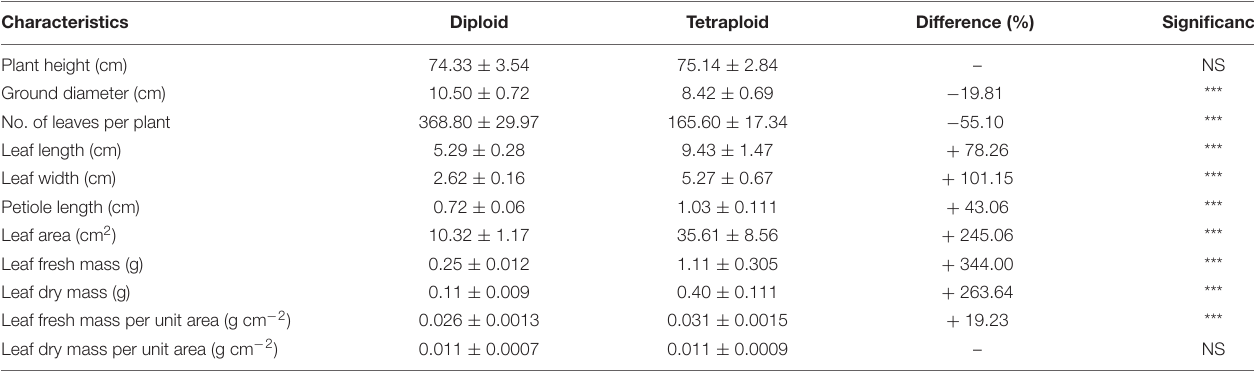
FIGURE 3 | Morphological features of diploid and tetraploid plants in E. urophylla. (A) Clonal propagation ramet of diploids (left) and tetraploids (right); and (B) fully expanded leaf blades of diploids (left) and tetraploids (right). TABLE 3 | Growth characteristics of tetraploid and diploid Eucalyptus urophylla